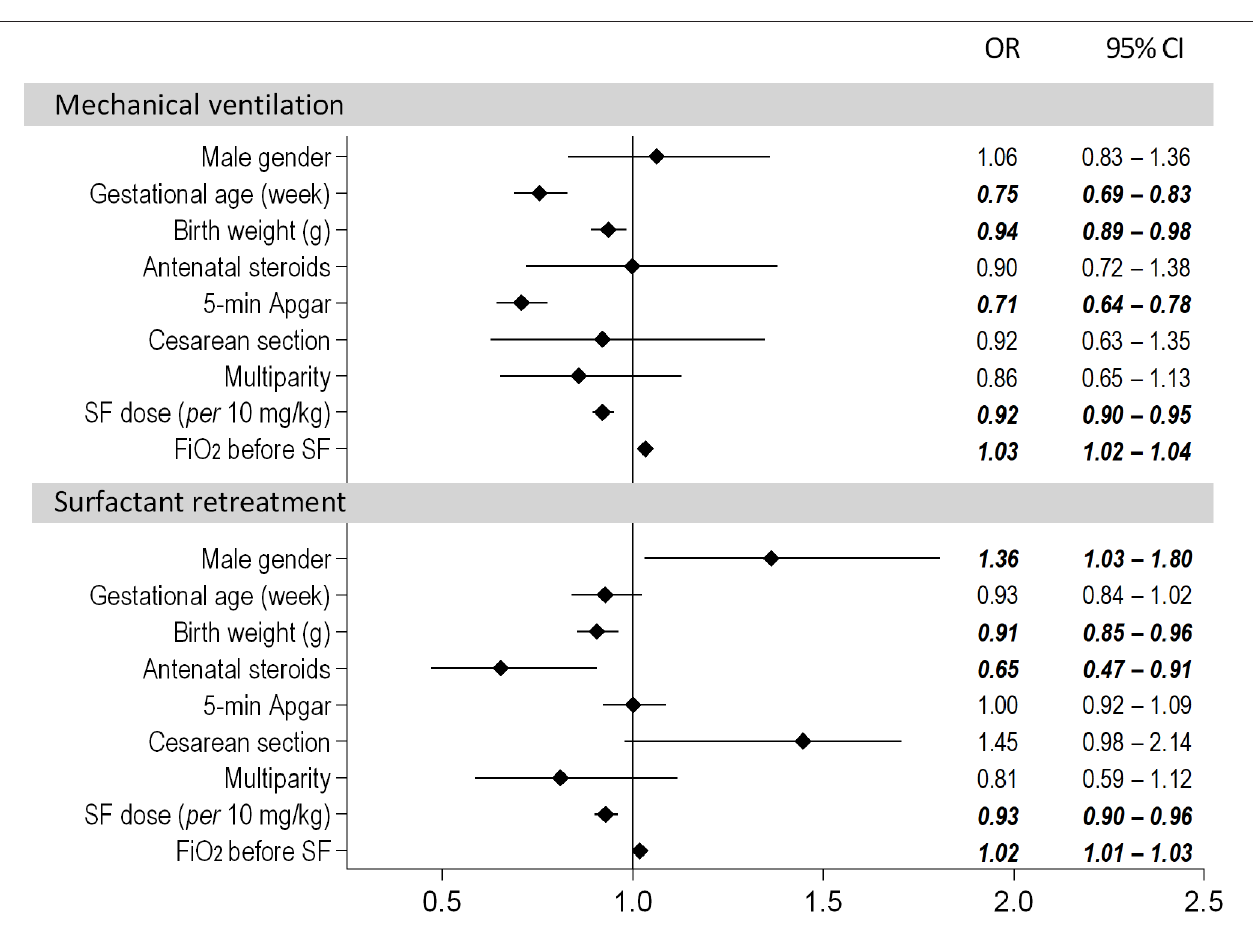
− 11 mg/kg for 26–28 weeks, − 15 mg/kg for 28–30 weeks, − 20 mg/kg for 30–32 weeks, and − 23.5 mg/kg for > 32